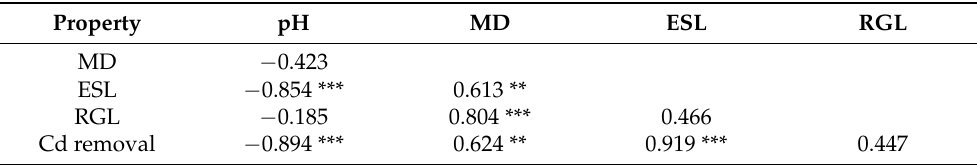
Table 3. Pearson correlation analysis between soil Cd removal and solution environmental fac- tors, including pH, MD (microbial density), ESL (elevated sulfate radical level), and RGL (reduced glucose level).